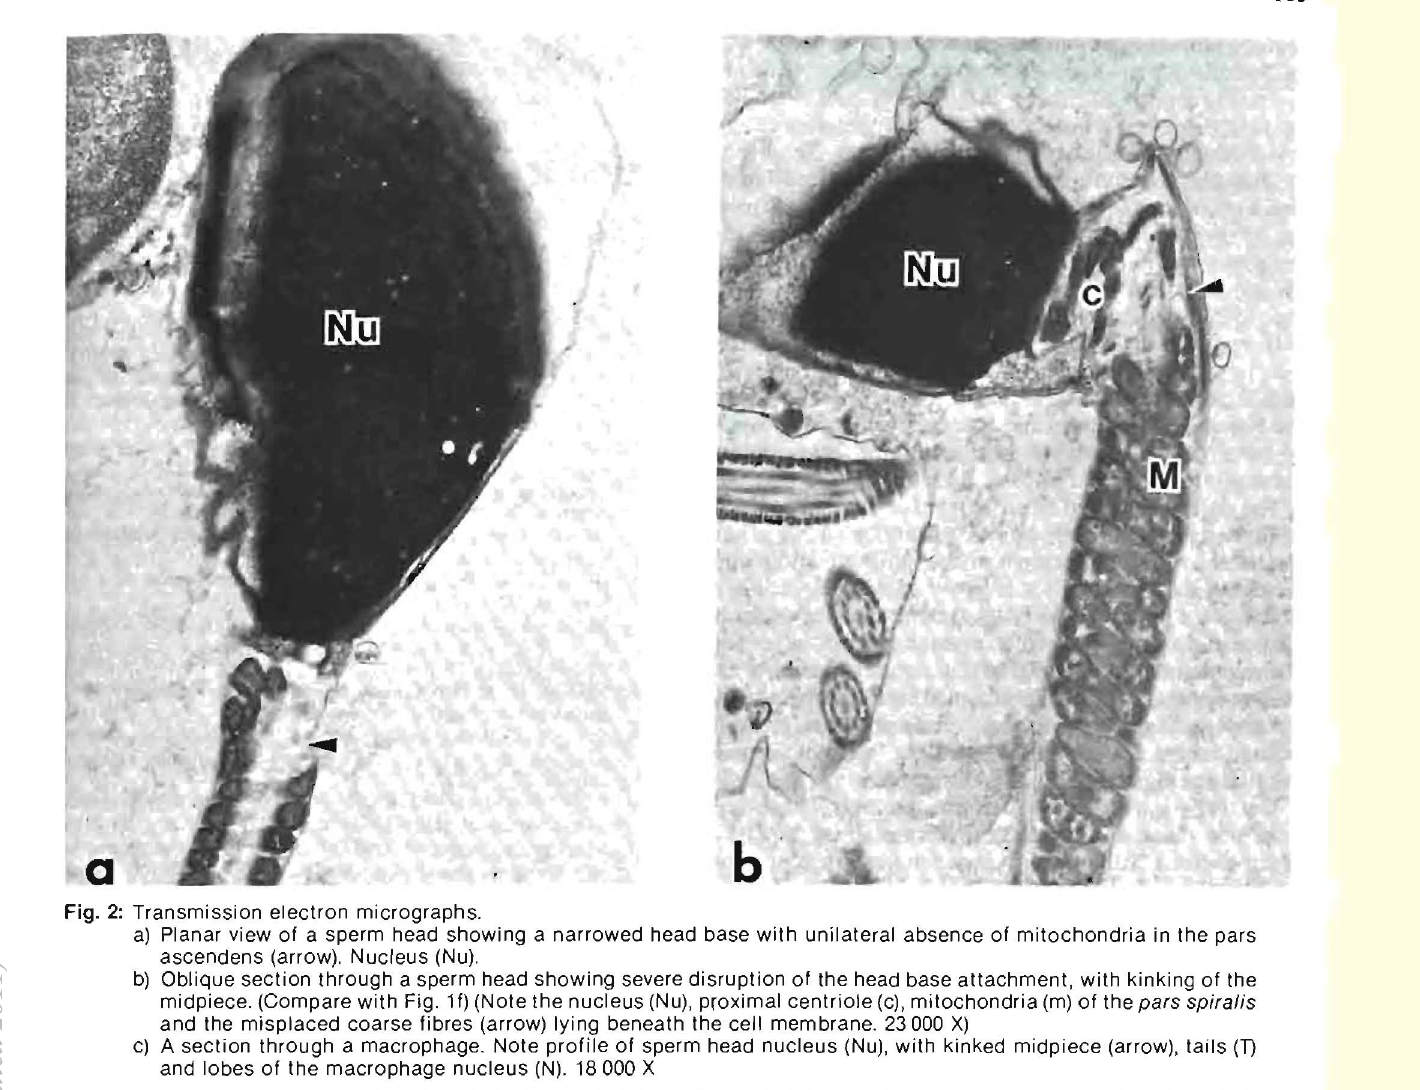
Fig. 2: Transmission electron micrographs. a) Planar view of a sperm head showing a narrowed head base with unilateral absence of mitochondria in the pars ascendens (arrow). Nucleus (Nu). b) Oblique section through a sperm head showing severe disruption of the head base attachment, with kinking of